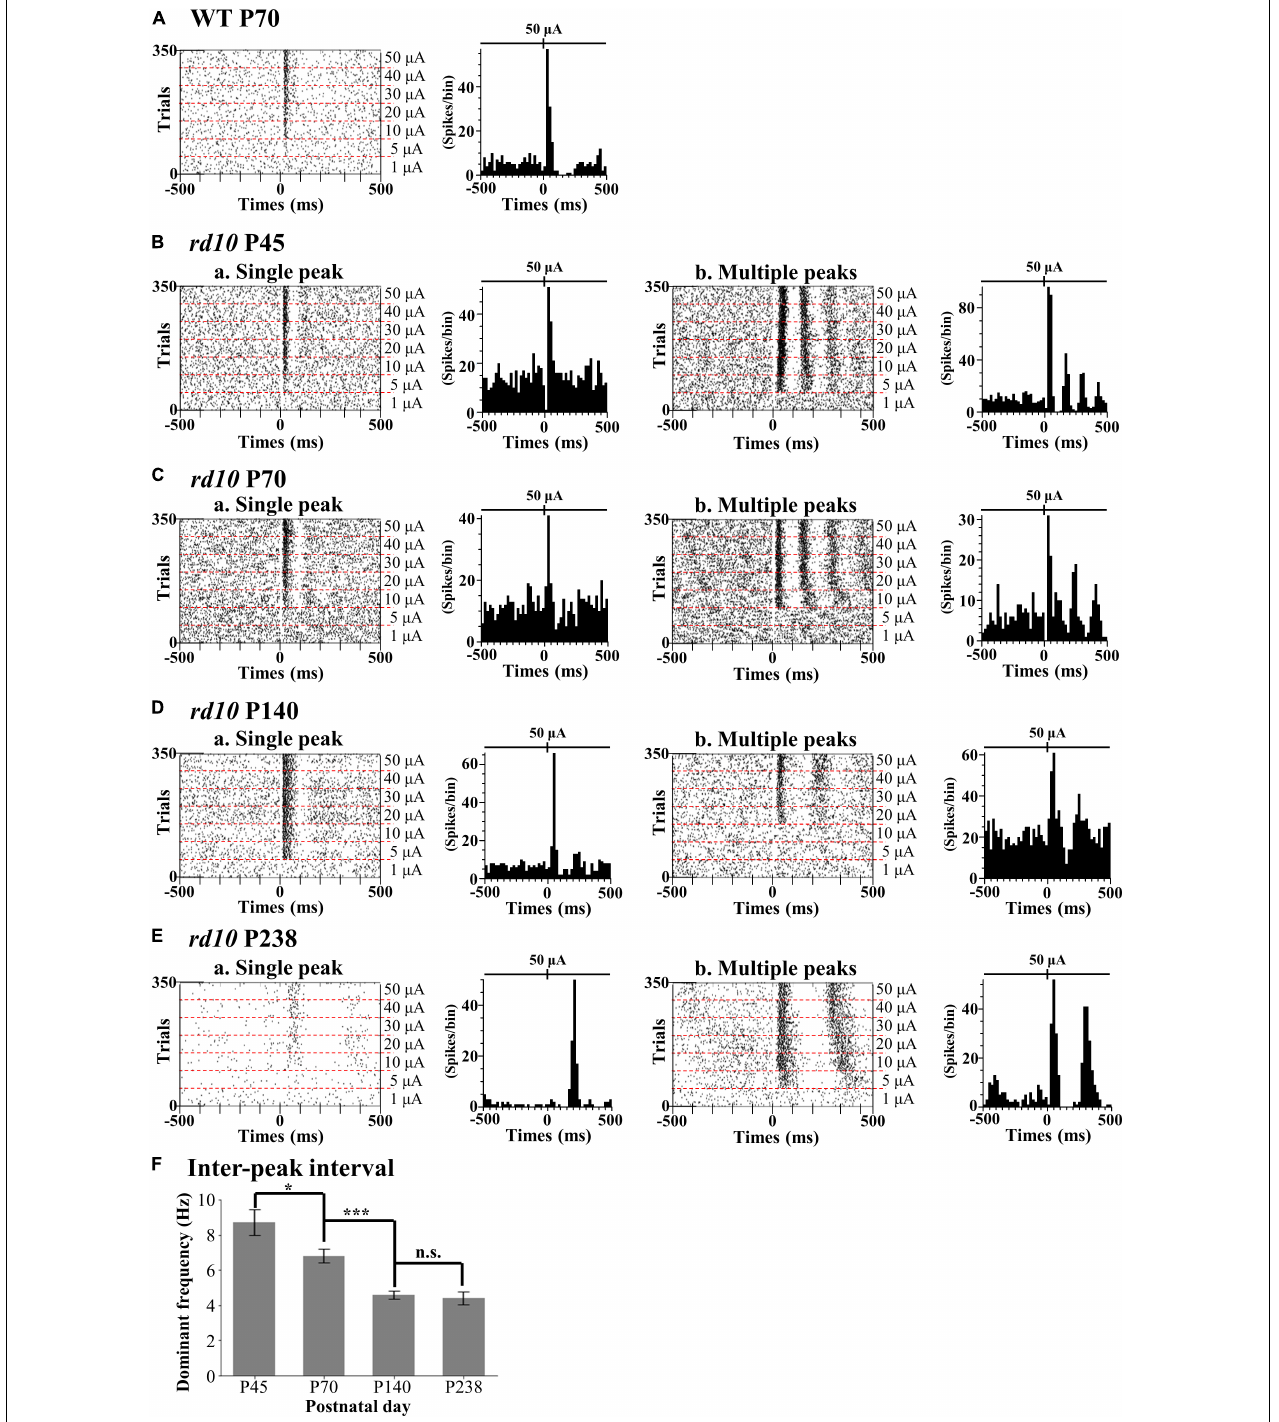
FIGURE 7 | Two different response patterns of the electrical stimulation-responsive retinal ganglion cells (ER-RGCs) according to postnatal ages. Typical response patterns to amplitude-modulated electrical stimulation in the wild-type (WT) group at P70 (A) and rd10 groups at P45 (B) , P70 (C) , P140 (D) , and P238 (E) are represented by a raster plot (left panel) and PSTH (right panel). We divided RGCs of rd10 mice into two groups, single peak (a) and multiple peaks (b) based on the number of peaks in PSTH. The time window of the raster plot and PSTH is set for ± 500 ms. The 0 ms represents the time point of stimulus onset. In each raster plot, the stimulation amplitude increases from the bottom to the top row. PSTHs represent electrically evoked RGC response at the strongest pulse amplitude (50 µ A). The y -axis of PSTH represents the spike number per bin (bin size is 20 ms). (F) The inter-peak frequency decreased from P45 to P140 and saturated. The average dominant frequency is shown for each degeneration stage, with error bars representing standard errors. Statistical significance between the average dominant frequencies was calculated for consecutive postnatal days using Student’s t -test (*** p < 0.001, * p < 0.05, and n.s., p > 0.05).